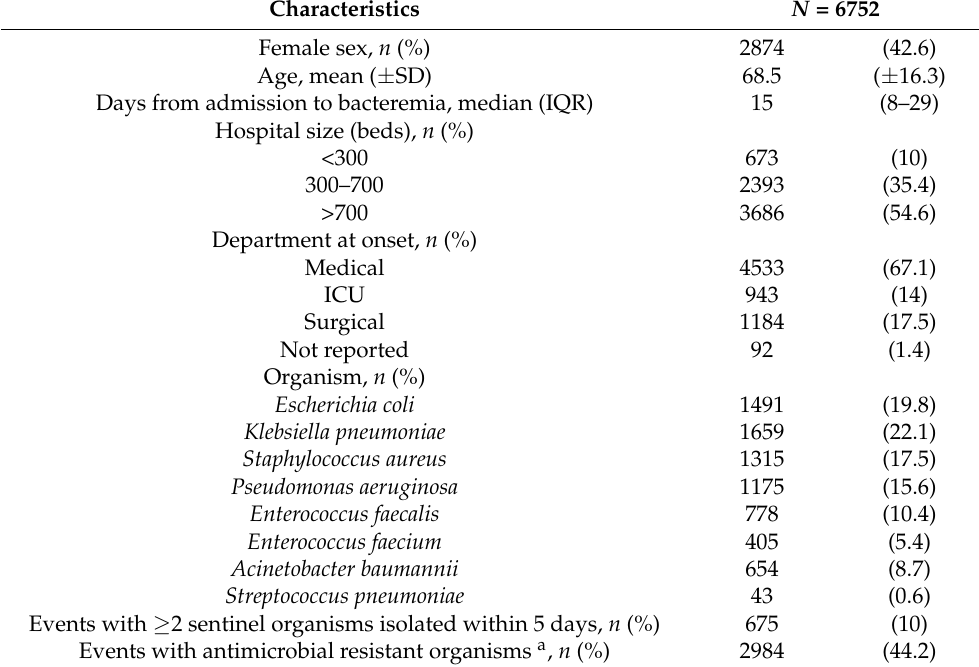
Table 1. Characteristics of hospital-onset bloodstream infections (HO-BSIs) caused by sentinel bacteria among adult patients, Israel, 2018–2019.